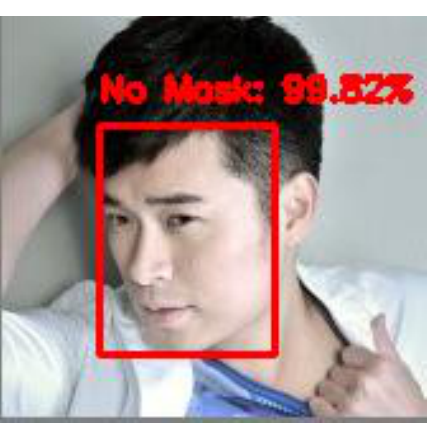
Figure 11. Detection of no mask with 99.82% probability